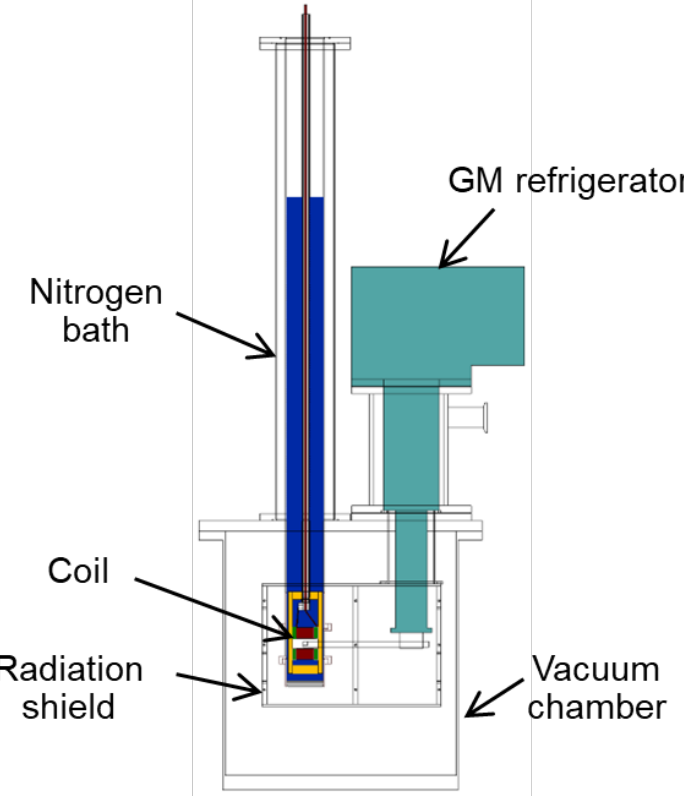
Figure 4. Cross-sectional view of the new pulsed magnet system.